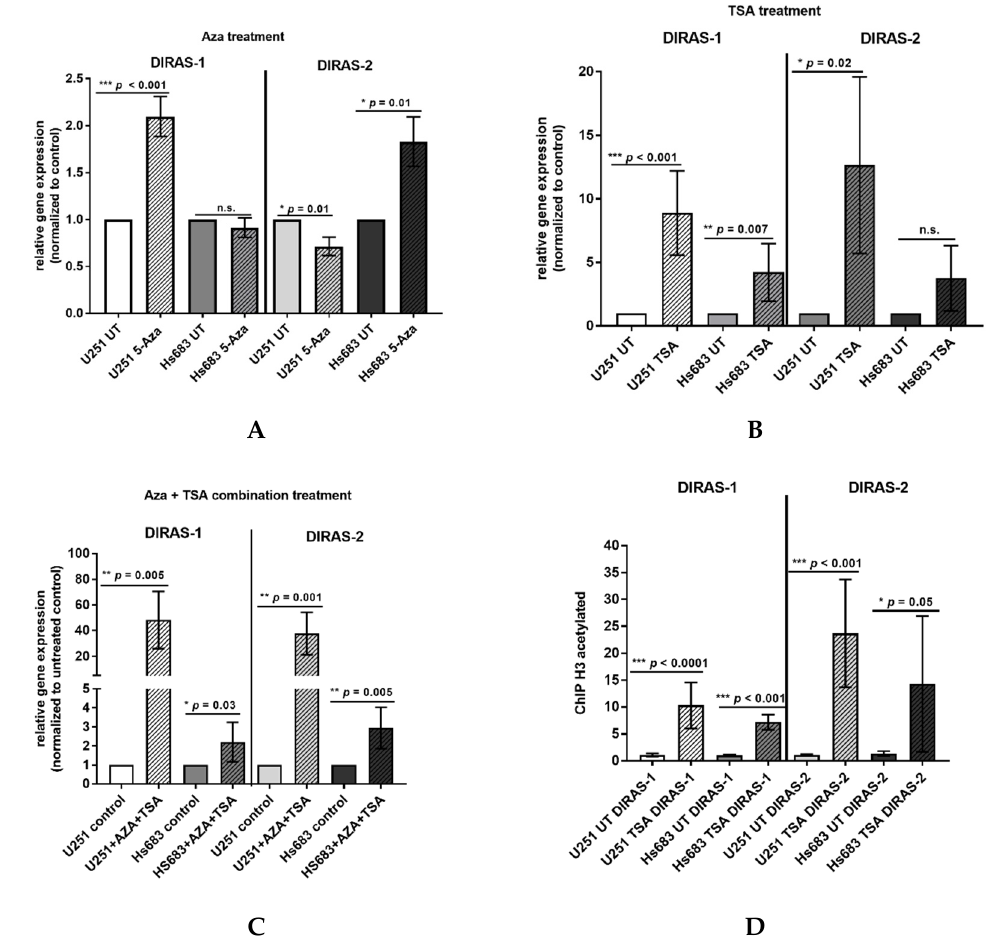
Figure 3. Hypermethylation and histone modifications account for transcriptional downregulation of DIRAS-1 and DIRAS-2. ( A ) Increase in DIRAS-1 and DIRAS-2 mRNA expression in U251MG and Hs683 cells after treatment with 5-azacytidine, ( B ) after treatment with trichostatin A (TSA), and ( C ) after combinational treatment with 5-azacytidine and trichostatin A. ( D ) Increase in DIRAS-1 and DIRAS-2 promoter DNA bound to acetylated H3, indicating DIRAS-1 and DIRAS-2 promoter euchromatinization after TSA treatment in U251MG and Hs683 cells (n.s.: not significant, * p ≤ 0.05, ** p ≤ 0.002, *** p ≤ 0.001). Original figure in Figure